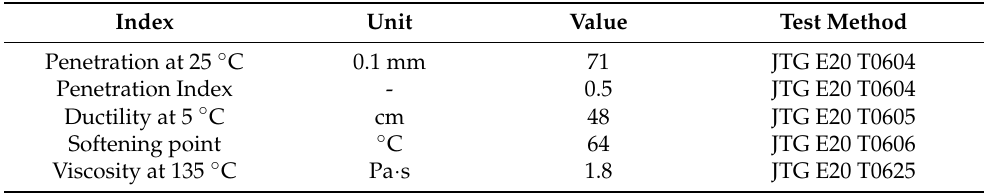
Table 1. Properties of SBS asphalt.